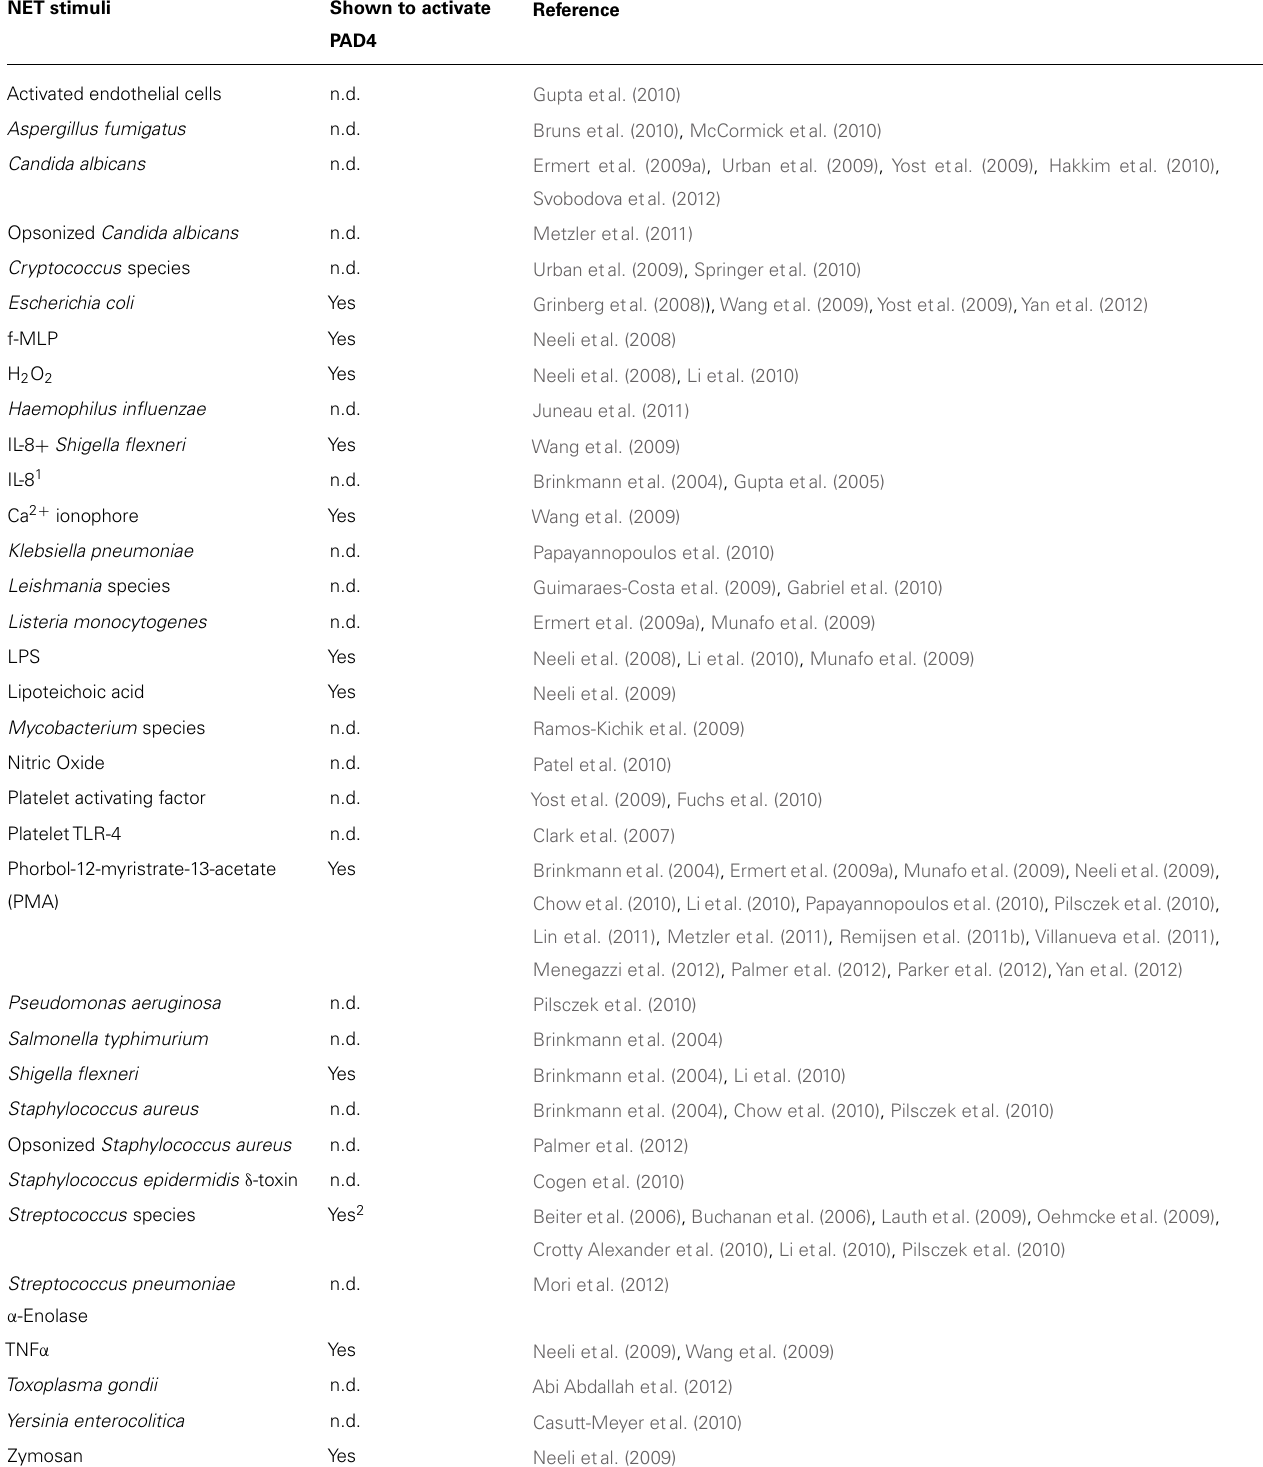
Table 1 | NET/PAD4